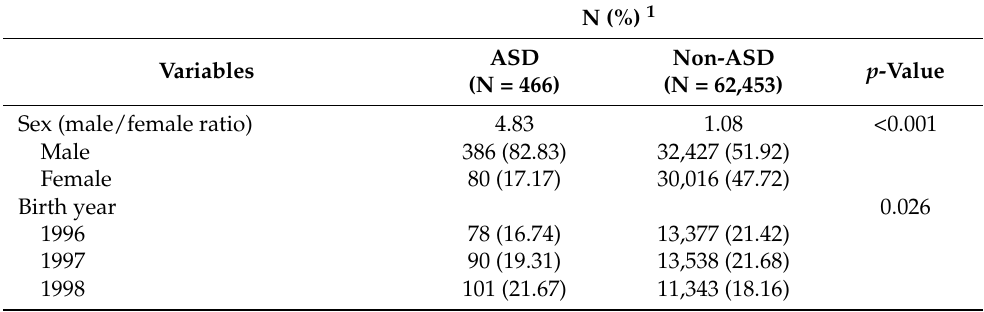
Figure 1. Flow chart of the study. Table 1. Comparison between cohort members with (ASD) and without (non-ASD) autism spectrum